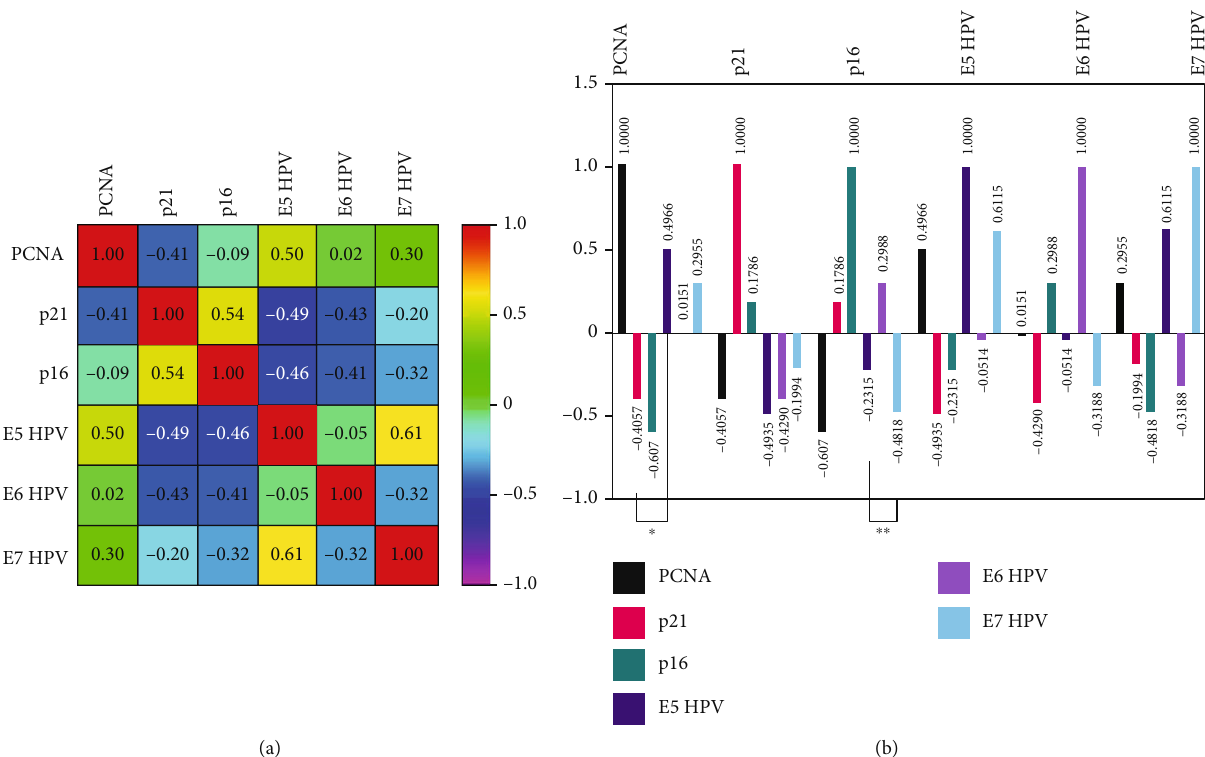
Figure 7: Correlation analysis in FF samples. (a) Heatmap of Spearman ’ s correlation test between E5, E6, E7, p21, p16, and PCNA in FF samples. r coe ffi cient is placed inside the cells with a variation from 1 (strongest positive correlation) to -1 (strongest negative correlation). (b) Correlation between all targets in FF samples. Each gene section shows the positive ( r = 1 ) or negative ( r = − 1 ) correlation coe ffi cient in the bar notation of the analyzed target. p value: ∗ < 0.05; ∗∗ <